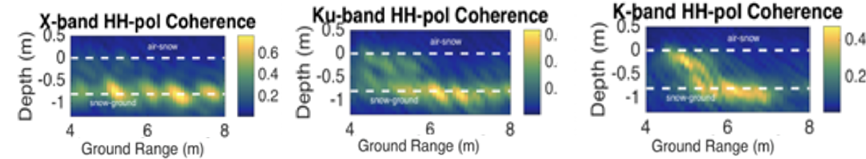
Figure 19. TomoSAR coherence images for HH polarization at 9.6, 13.5, and 17.2GHz at Fraser, CO, sites.